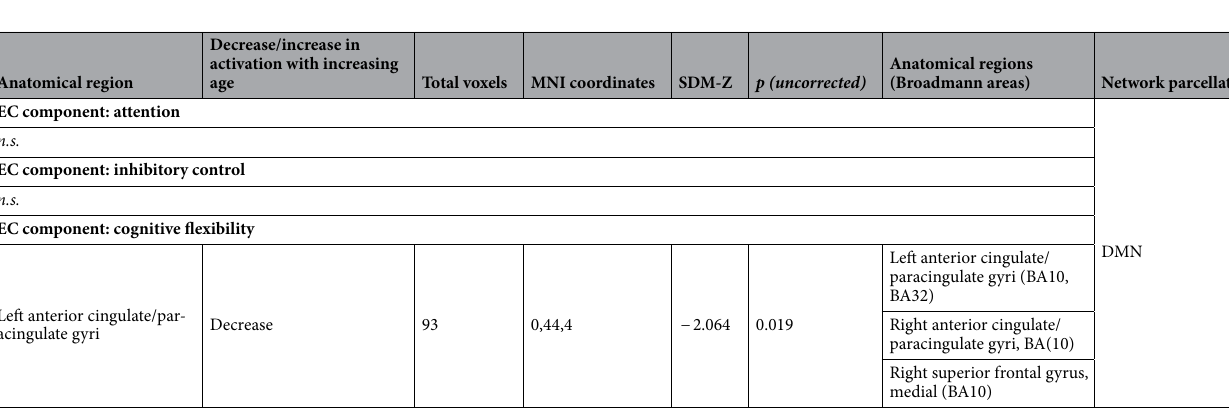
Table 5. Meta-regression of EC components with age as a regressor. FPN fronto-parietal network, SMN somato-motor network, DMN default mode network, n.s .